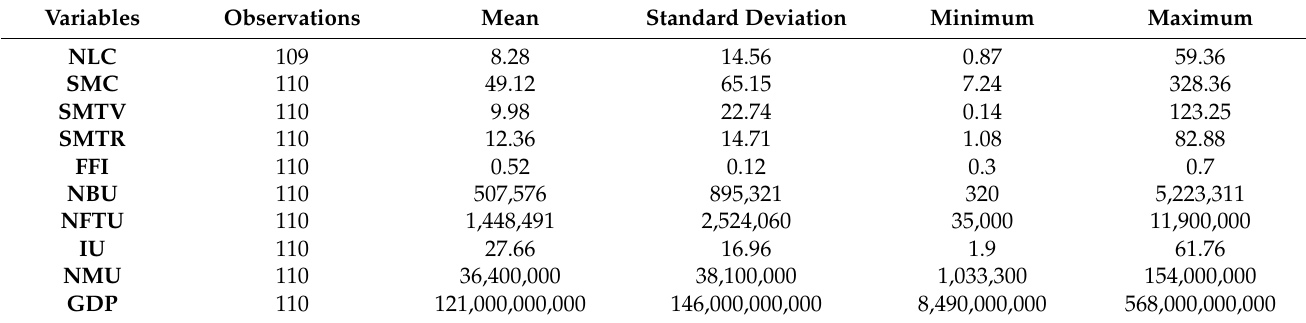
Table 4. Summary